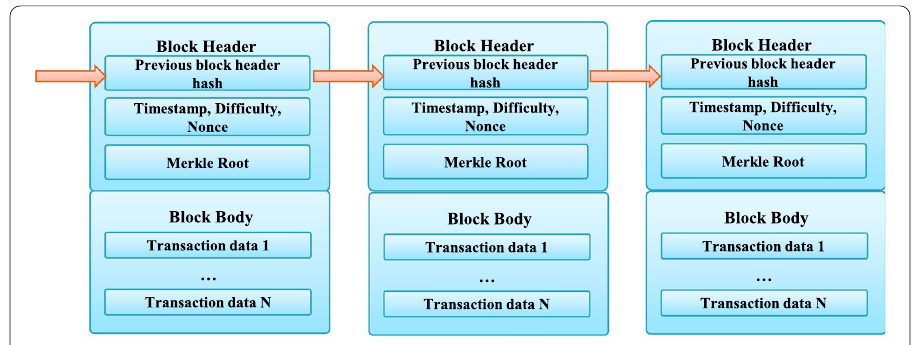
Fig. 2 Data structure of